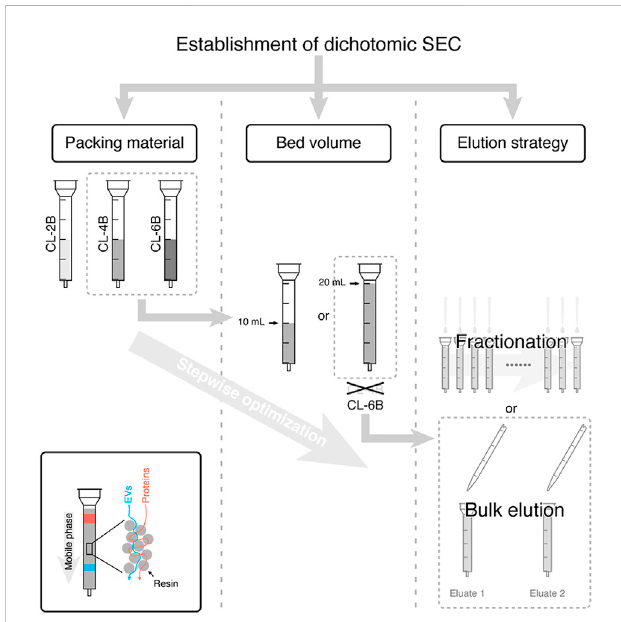
FIGURE 2 Establishment of dichotomic SEC. The dichotomic SEC separation with 2 bulk elution steps was suf fi cient for the isolation of the extracellular vesicle. When the packing material is CL-6B and the bed volume is 20 mL, it will be the best separation performance. Reproduced with permission from (Guo et al.,